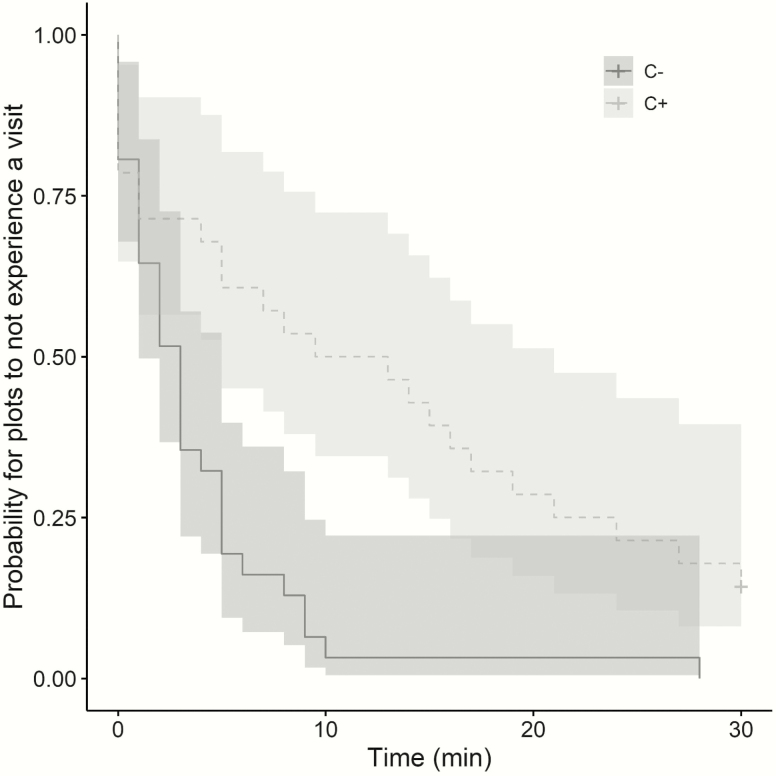
Survival curves representing the time to first visit on plots (or the probability for plots of S. alba to not experience a visit across time), without (C−) and with competition (C+). It can be interpreted as the proportion of plots yet to be visited for a given time or the time it takes for a given proportion of plots to experience a visit, across time. The time represents the number of minutes since nylon mesh cage removal. Grey areas around the curves correspond to the 95 % confidence interval of a Kaplan–Meier test (P = 7.20e-04).